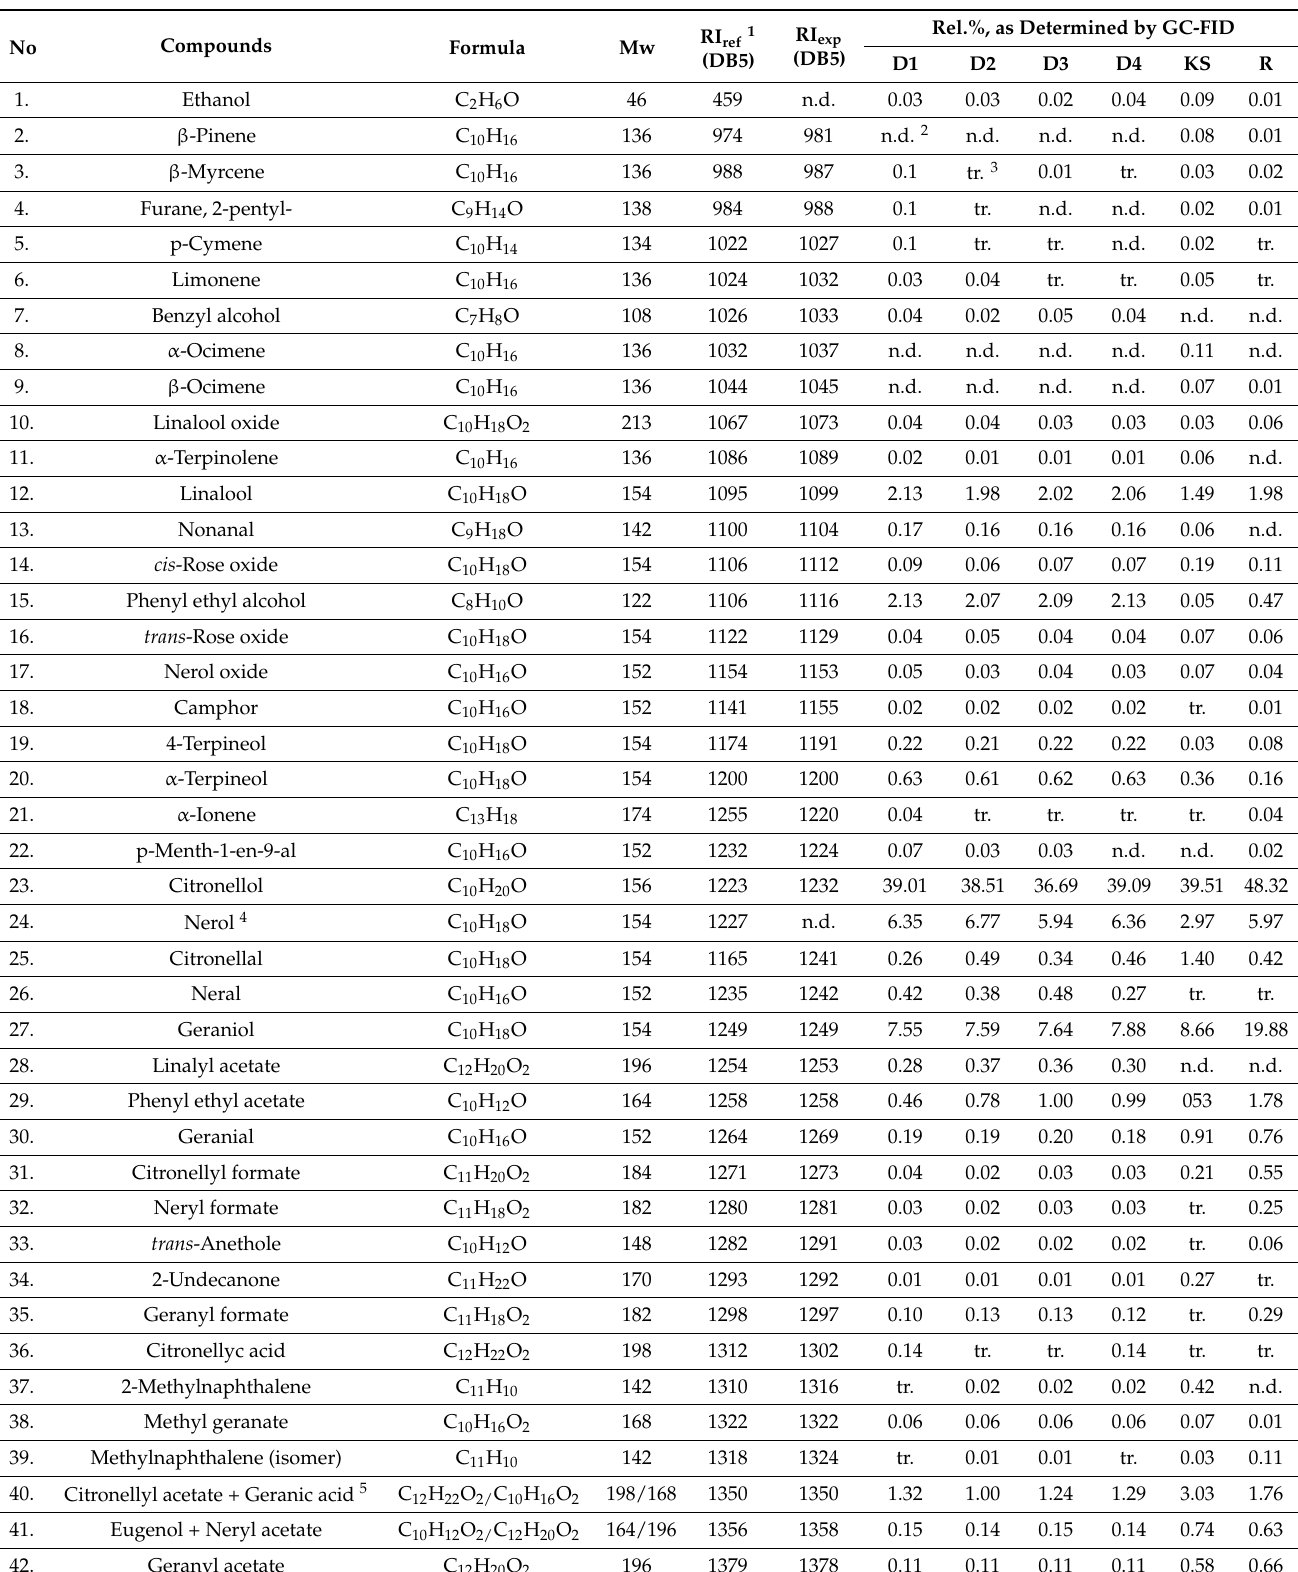
Table 1. Chemical composition of the rose oils samples, as determined by GC/MS/FID on a DB-5ms